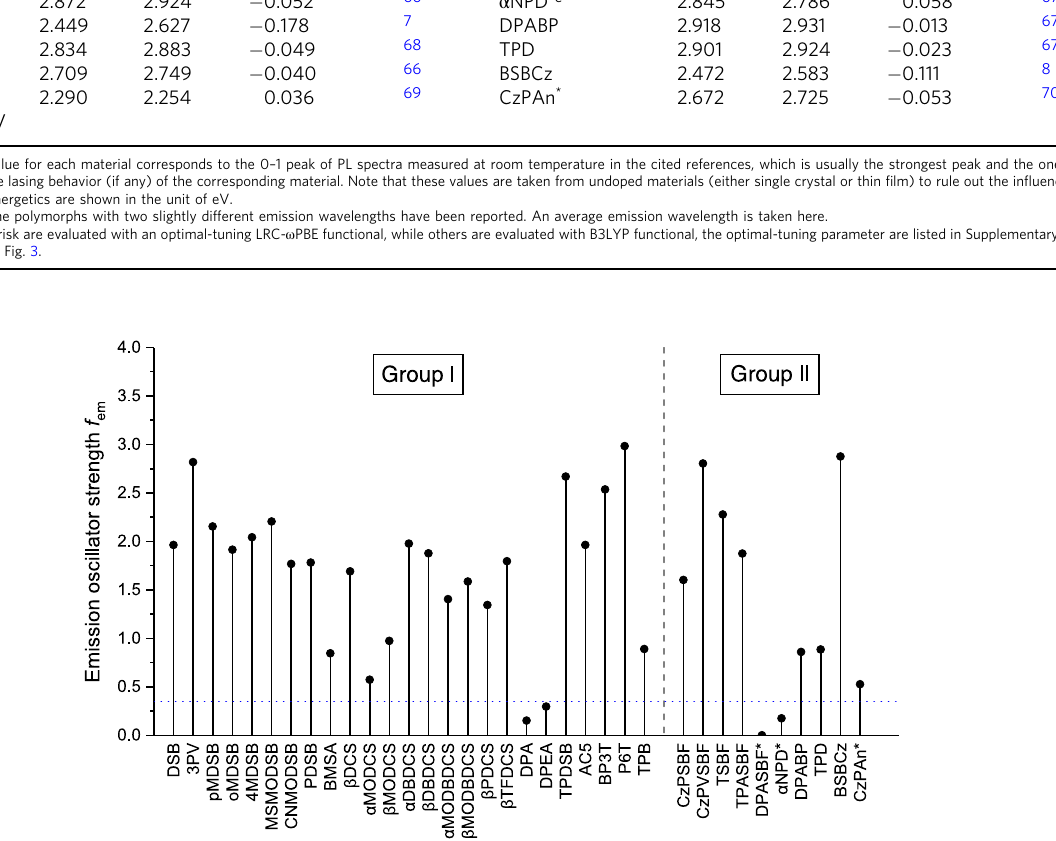
Fig. 3 Emission oscillator strengths f em of all investigated materials. Molecules with asterisk are evaluated with an optimal-tuning LRC- ω PBE functional, while others are evaluated with B3LYP functional. The blue dotted line denotes f em = 0.35. Four non-lasing materials, i.e., DPA, DPEA, DPASBF, and α NPD, have signi fi cantly smaller f em